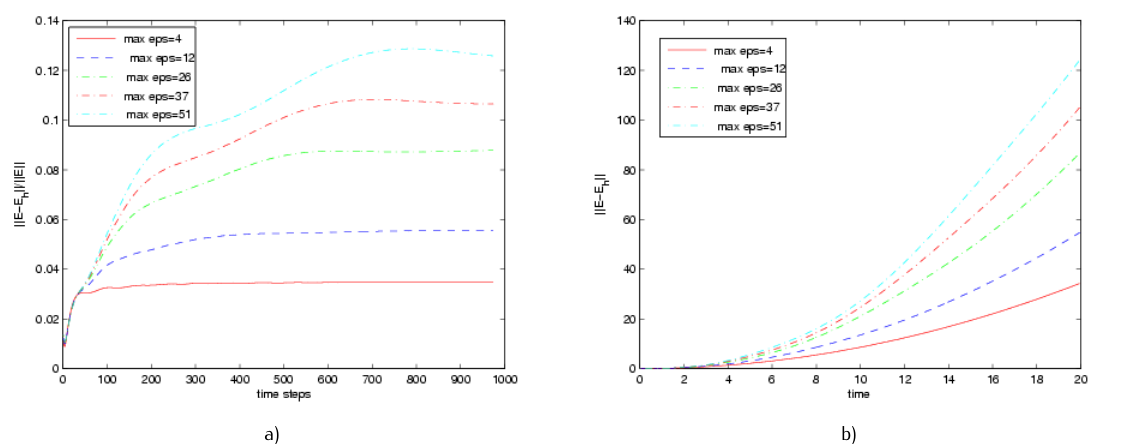
Figure 11. Test 1. a) relative errors kE−E h k L 2(ΩFEM) /kEk L 2(ΩFEM) during time T = (0 , 20) ; b) norms kE−E h k L 2(ΩFEM) during time T = (0 , 20) .